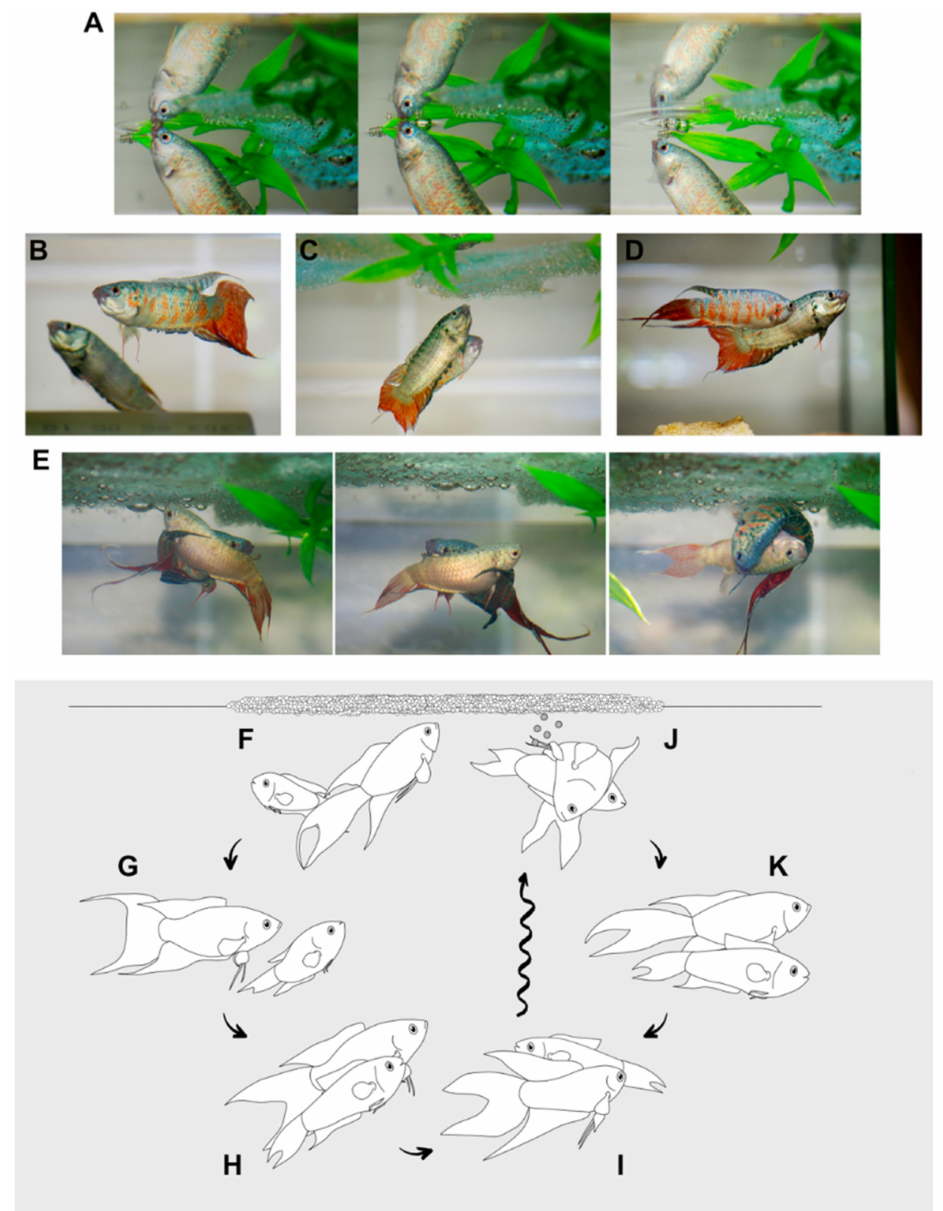
Figure 3. Reproductive behavior of the paradise fish. ( A ) Male paradise fish building nest, by ejecting mucus covered bubbles ( A , B ). ( B ) Paradise fish males show lateral spread display (LSD) behavior towards female fish in courtship. ( C , D ) Paradise fish courtship behavior: female fish check nest ( C ) or refuse male’s invitation by showing aggressive displays (OPE—opercular erection, LSD), vibrating movement (VIB) towards male fish ( D ), or even escape (ESC). ( E ) Paradise fish performing circling (CIR) followed by anabantoind embrace (ANE). ( F – K ) Step by step illustration of courtship behavior at M. opercularis . ( F ) Male fish building nest ( A , B ), ( G ) male fish starts lateral spread display (LHH), ( H ) male leads female to the bubble nest (LEN), ( I ) female shows a vertical waggle (VEW) followed by circle swimming (CIRC) under and toward nest, ( J ) anabantoid embrace (ANE) and release of gametes, ( K ) swimming inhibition (SIN). Steps I to K are repeated approximately 12–15 times, until the spawning process is finished (2–3 h). Drawing credit: Ren á ta Hamar, photo credit: Anita R á cz. Oblique Movements (OBM) and Vertical Waggle (VEW) This posture is performed by females toward males or by submissive individuals toward dominant ones. The fins are folded, and the body may tilt vertically or horizontally. During mating, the lateral or vertical tilt usually changes into low-frequency tail